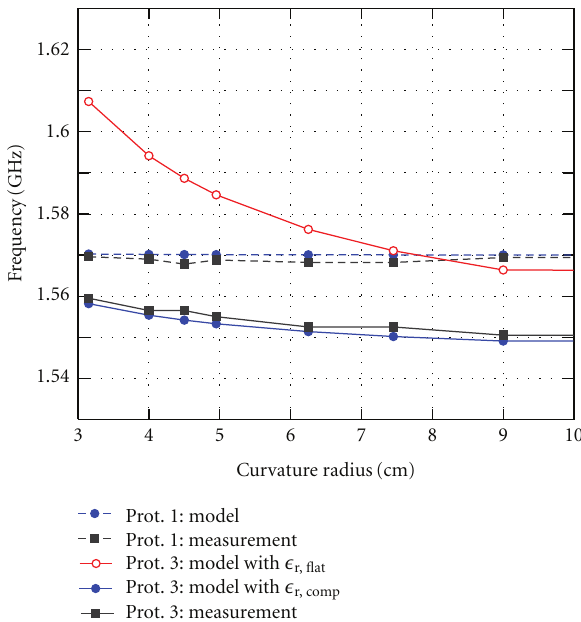
Figure 4: Resonance frequencies of prototypes 1 and 3 as a function of the bending radius when the antennas are bent along the W p direction.